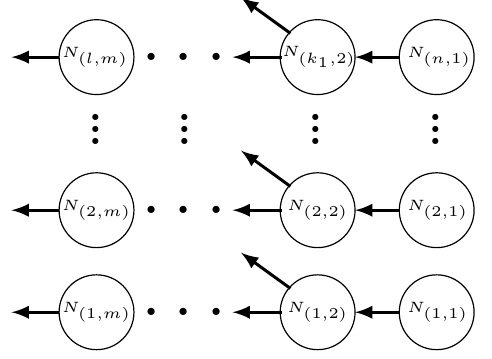
Figure 6. General branched pipeline system